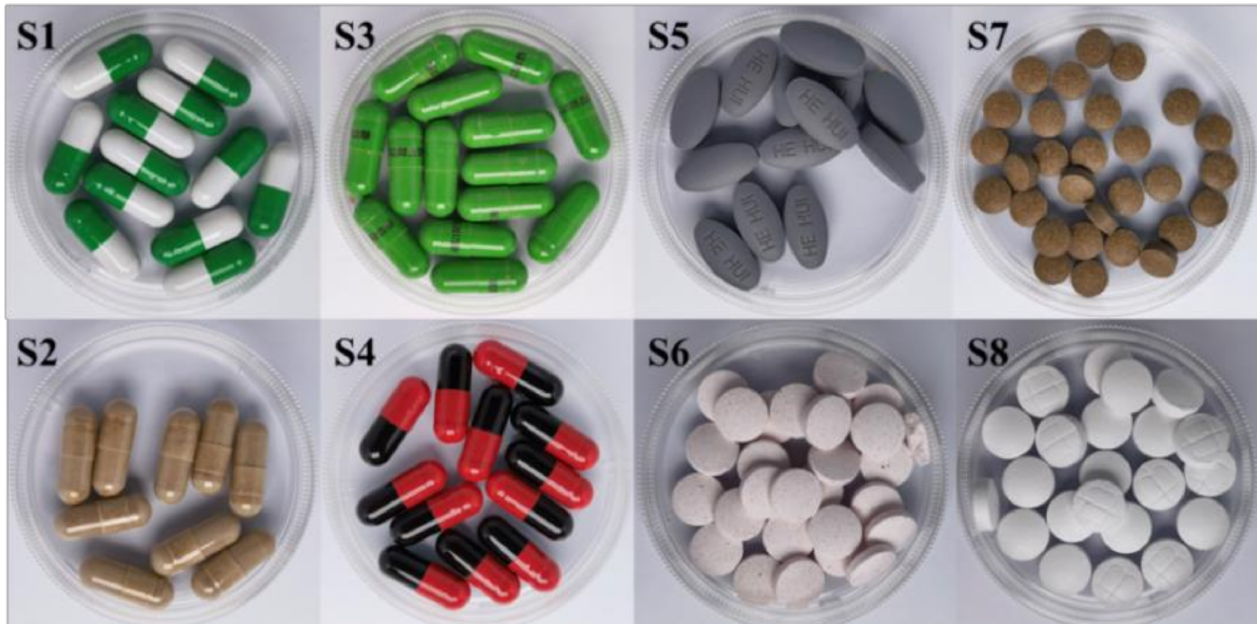
Figure 2. Eight real samples claiming anti-diabetic properties. S1~S4 were capsule samples with different matrices. S5~S8 were tablet samples with different